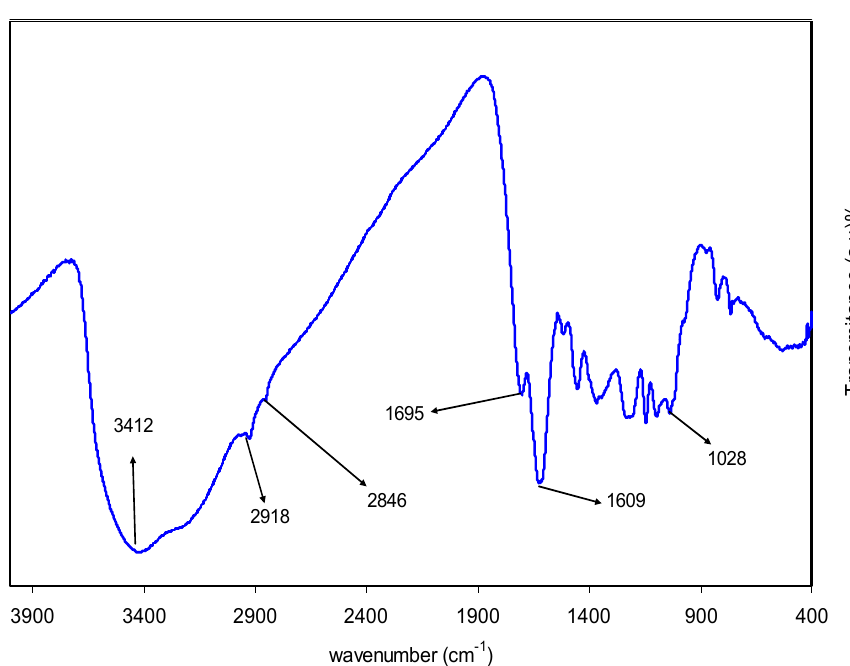
Figure 2. FTIR spectra of colloidal copper complex.